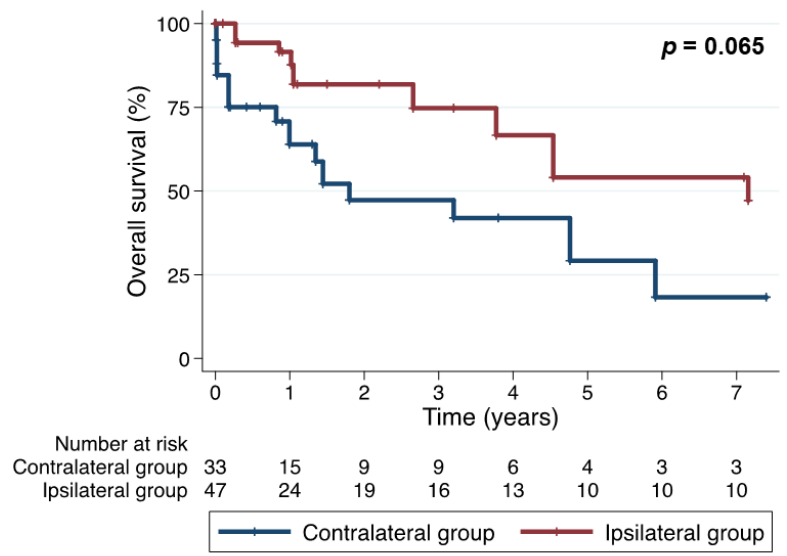
Figure 2. The overall survival comparison between the 2 groups (inverse probability weighting- adjusted comparison).